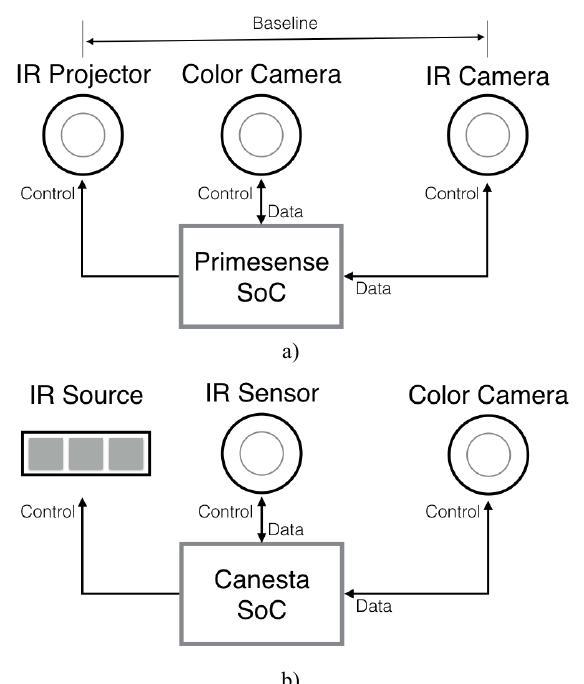
Figure 1. Block diagram of the two technologies employed in the analysed sensors: a) Primesense, based on triangulation; b) Canesta, based on Time of